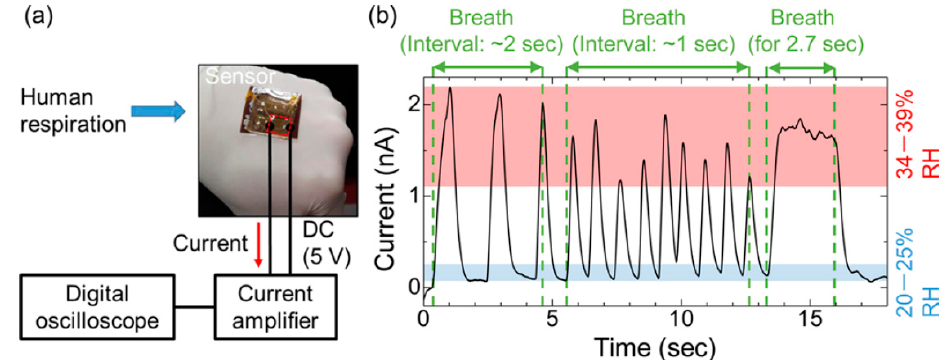
Figure 10. ( a ) Measurement system for monitoring human respiration. The device is mounted on a 125- µ m polyimide film for stable measurement. ( b ) Monitoring human respiration using the sensor. The used sensor is indicated by the dashed square in (a) [100] (reproduced with permission).